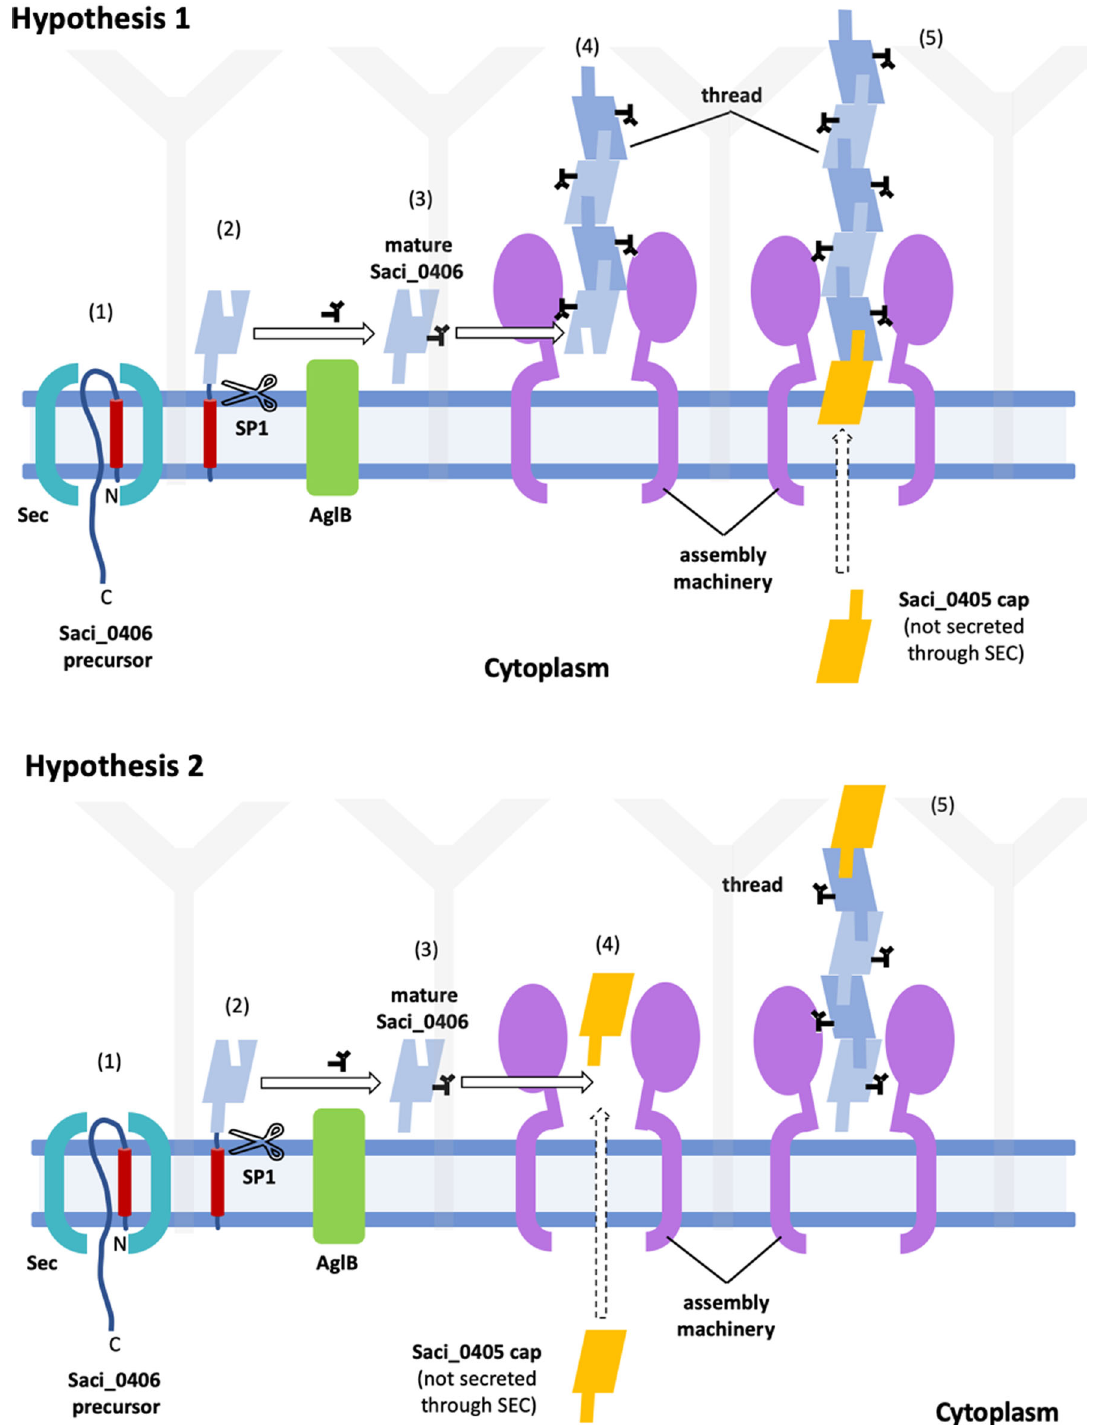
Fig. 4 | Hypothetical models for thread assembly. Saci_0406 precursor proteins areinitiallysecretedthroughtheSECtranslocon(1).Signalpeptidase1(SP1)cleaves the N-terminal signal peptide (2). The protein is glycosylated by AglB (3; glycans shown as black sticks). Soluble, mature Saci_0406 proteins assemble into the threadviadonorstrand complementation(4,5).This processmaybe spontaneous or catalysed by an assembly machinery. The putative cap protein Saci_0405 is not